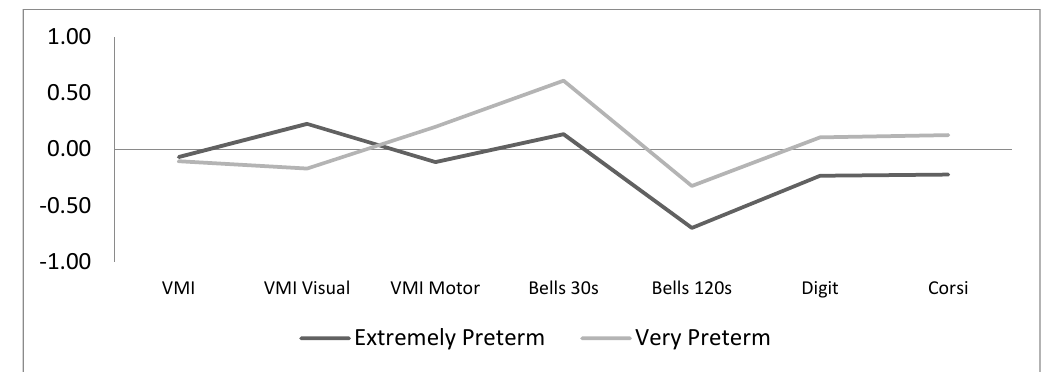
Figure 2. Neurocognitive profiles for the extremely preterm and very preterm children. Table 4. Summary of the neurocognitive skills for the extremely preterm and very preterm children.